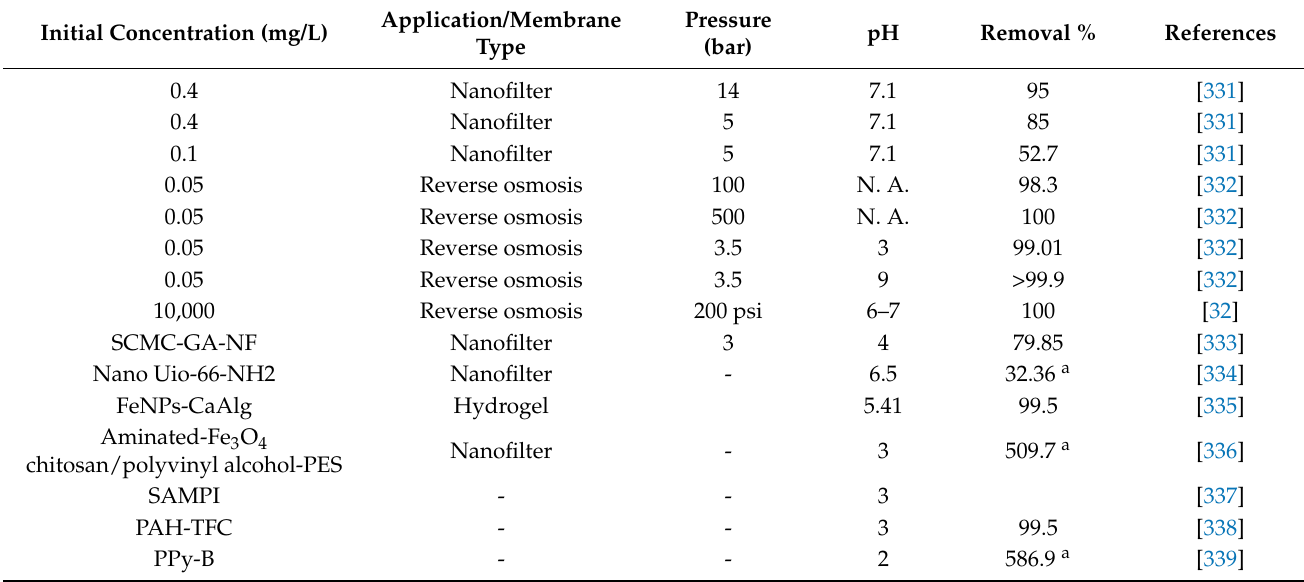
Table 7. The performances of membranes for the treatment of Cr 6+ (the superscript “a” denotes in